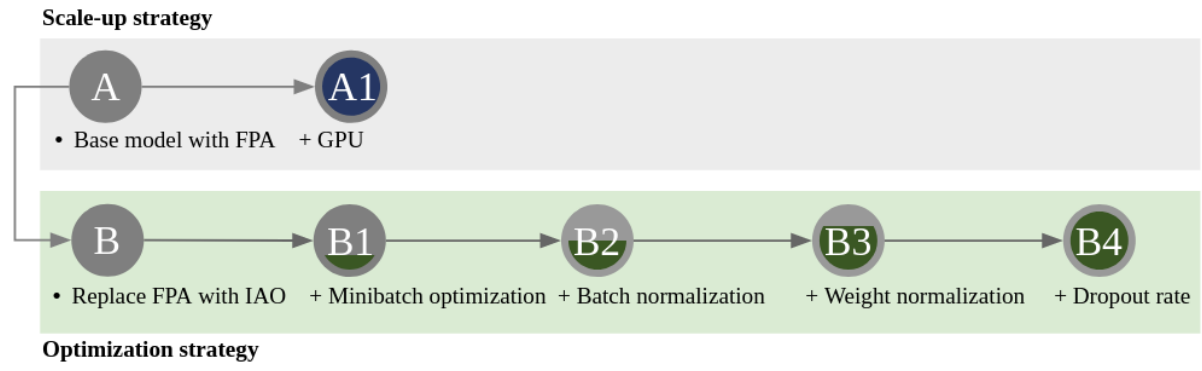
Figure 1. Two strategies will be compared. The lineage of model A is the implementation of the scale-up strategy (highlighted in blue). On the other hand, the lineage of model B is the implementation of the optimization strategy (depicted in green). Model A is the base model with FPA framework, while model B replaces the floating-point arithmetic with IAO. Each model is built on top of a predecessor model. For instance, model A1 is empowered with a single GPU and model B1 is empowered with the optimal minibatch size. FPA: floating-point arithmetic. GPU: graphics processing unit. IAO: integer arithmetic